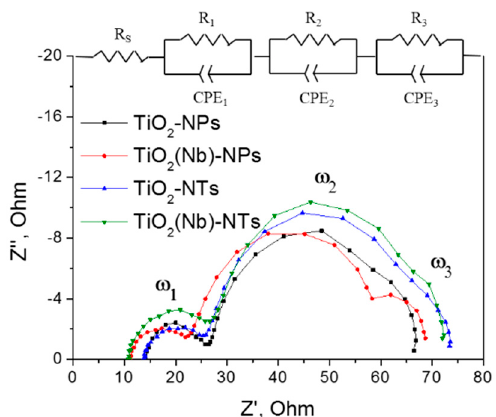
Figure 5. Nyquist plots of best performing DSCs based on TiO 2 NPs- and NTs- photoelectrodes and equivalent circuits used for EIS data fitting.